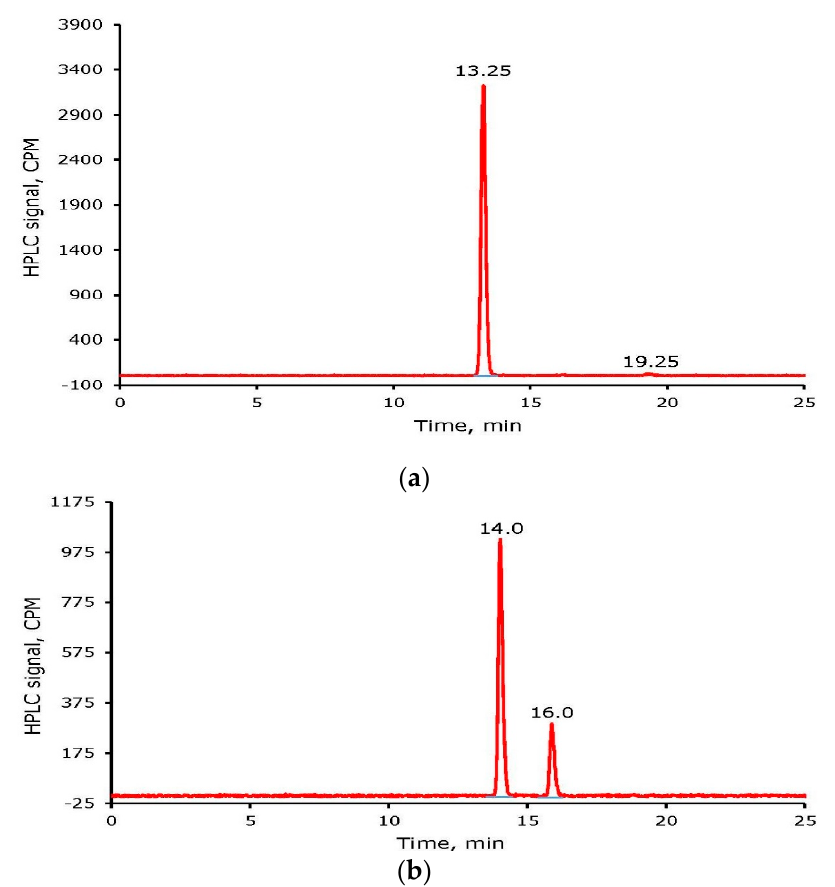
Figure 4. HPLC Chromatogram of radioiodine labeled tyrosine ( a ) and cyclo Arg-Gly-Asp-d-Tyr-Lys (cRGDyK) ( b ) after Sep-Pak purification.